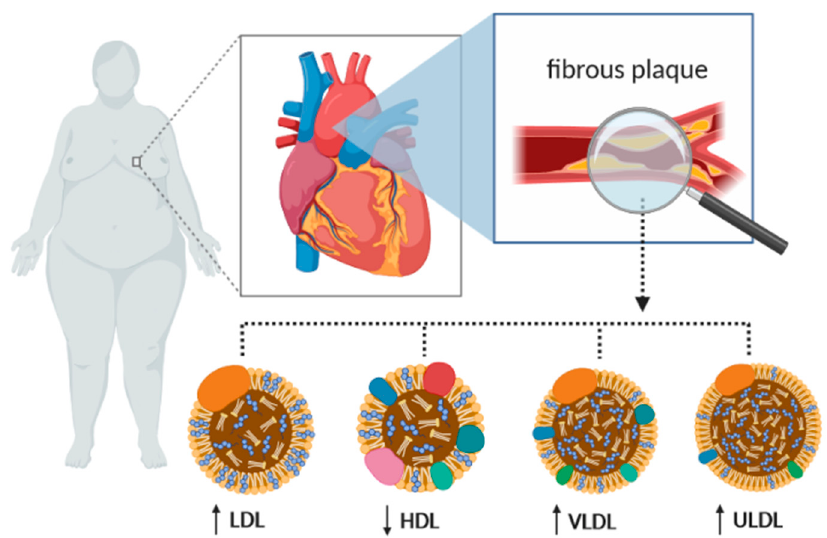
Figure 3. Lipid disorders impacted by RBP4 as the main levels of risk of cardiovascular disease caused by obesity. LDL—low-density lipoprotein; HDL—high-density lipoprotein; VLDL—very-low-density lipoprotein; ULDL—ultra low-density lipoprotein.